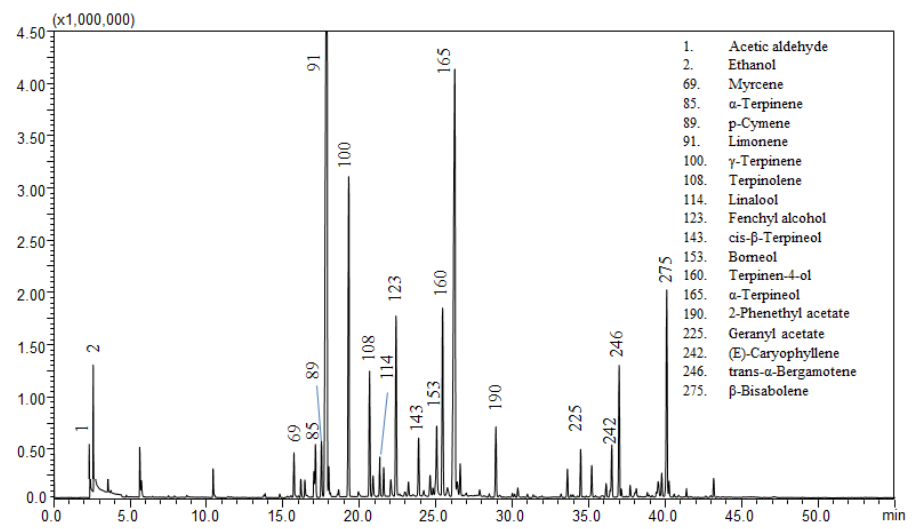
Figure 1. GC-MS analysis of the volatile profile for sample 11.